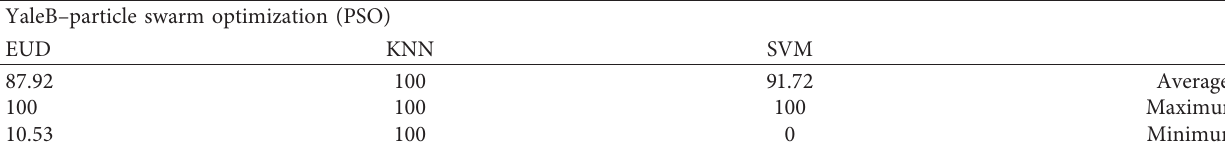
Table 2: Recognition accuracies for the YaleB database with the PSO